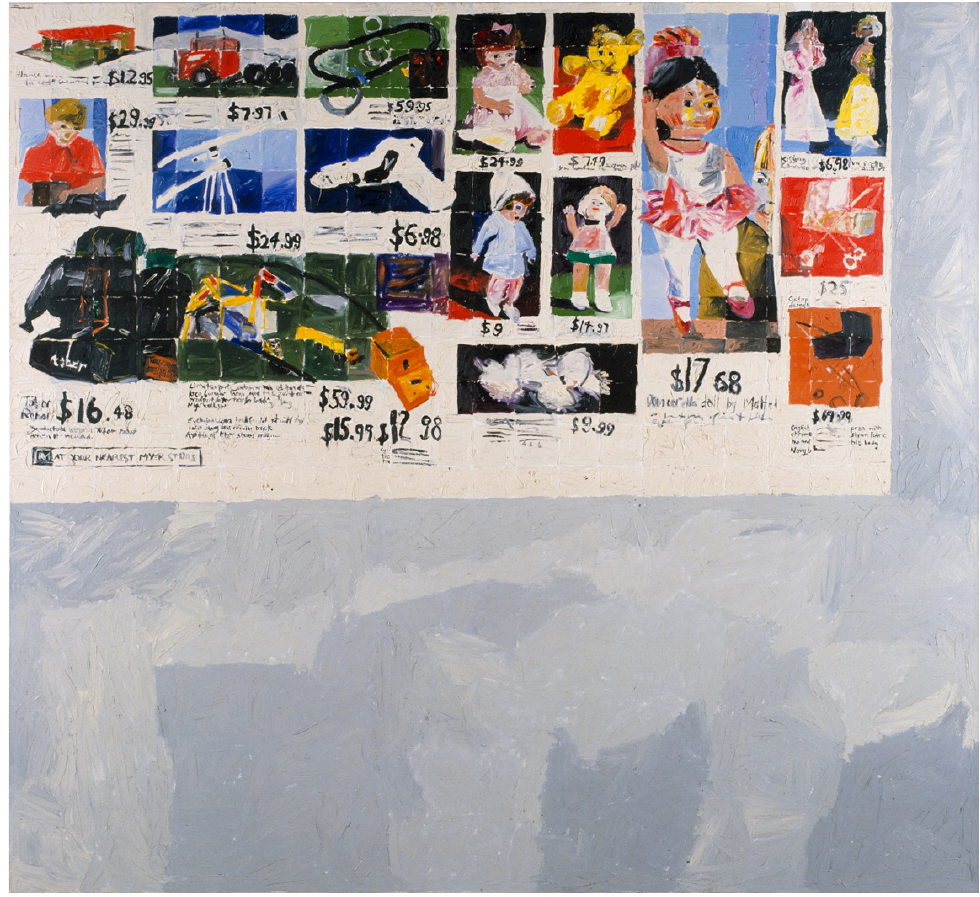
Jenny Watson, A Painted Page 3: Myer Christmas Catalogue 1979 , 1979, oil on canvas, 163 x 178 cm. Gold Coast City Art Gallery. Copyright Jenny